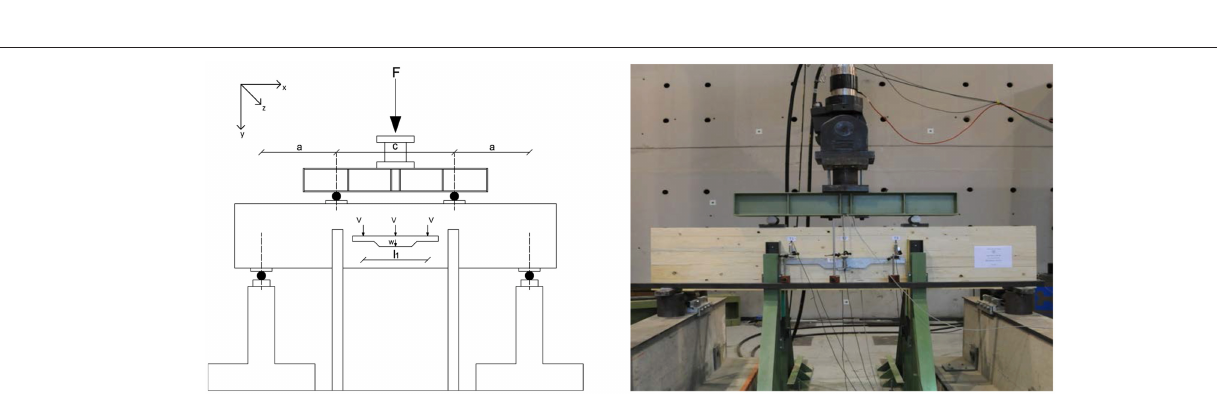
FIGURE 1 | Tested specimen: for each series of specimen an image is provided showing the layup in the thickness direction and underlining differences.